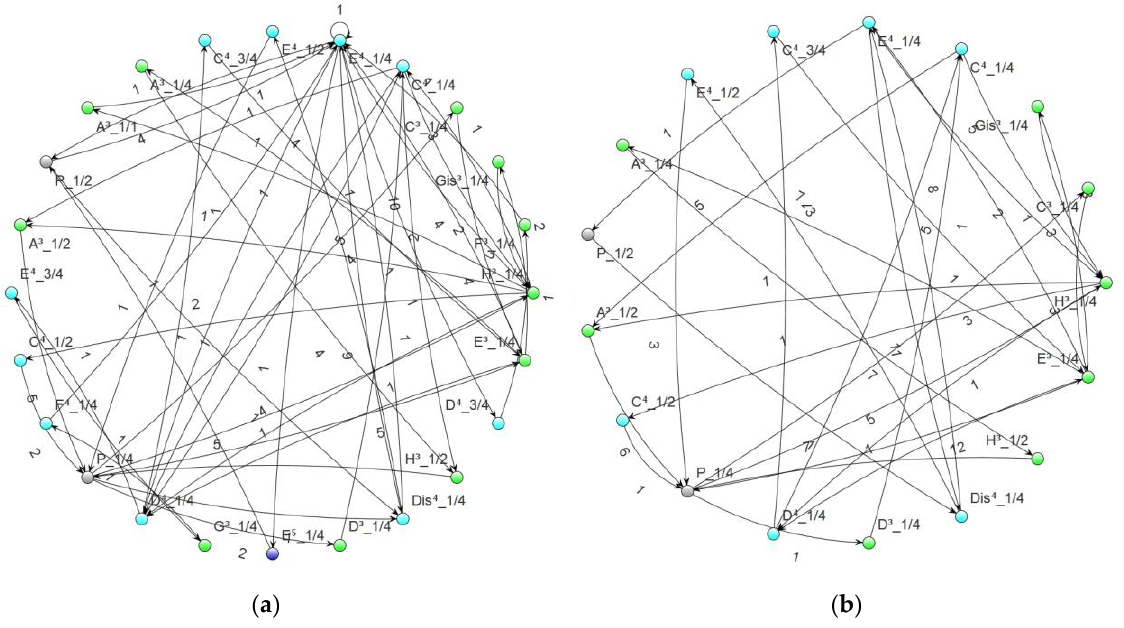
Figure 2. Representation of ( a ) the opening measures of Für Elise and ( b ) the arrangement based on it. The structure of both networks is similar; however, not all notes of the original piece were used in the arrangement (e.g., the quarter note E 5 visualized in dark blue at the bottom of the graph representing the original piece is not present in the arrangement).